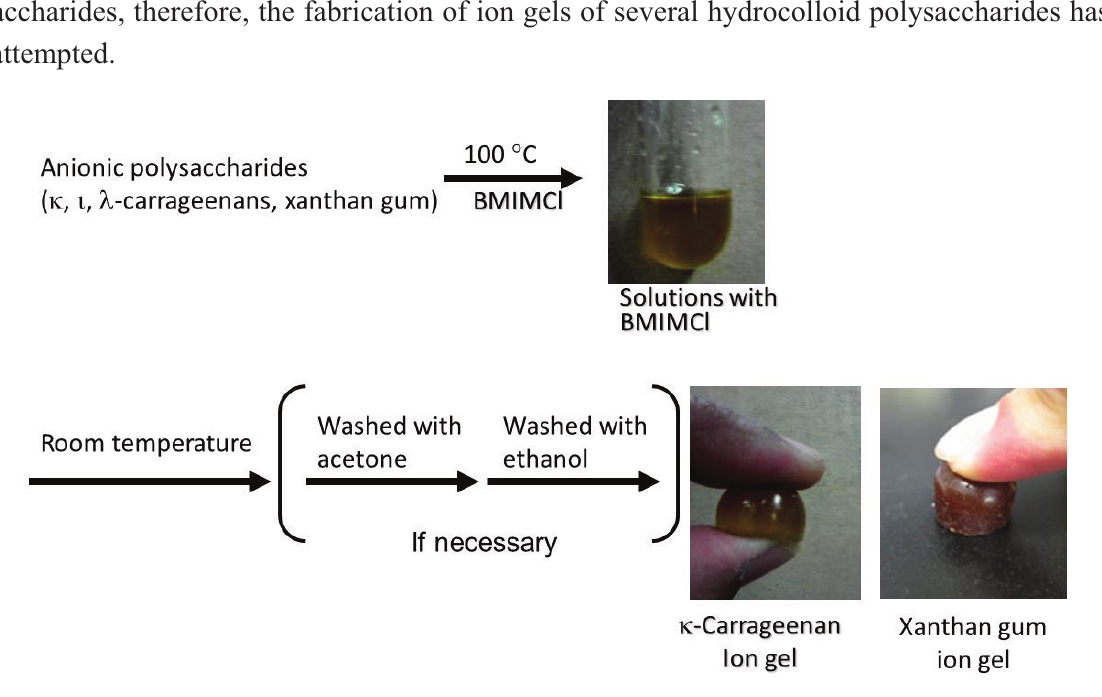
Figure 10. Procedure for fabrication of anionic polysaccharide ion gels with